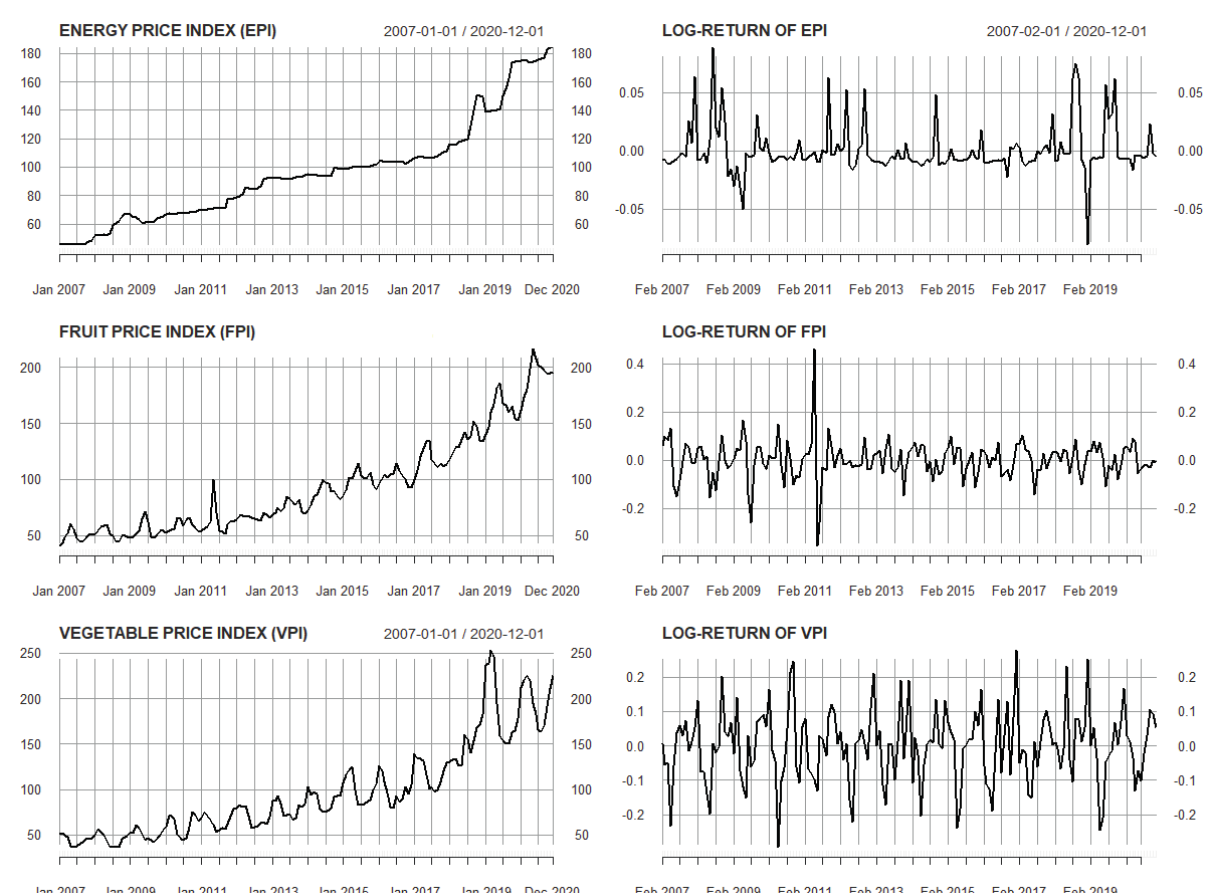
Figure 1. Time-series Plot of Indexes and